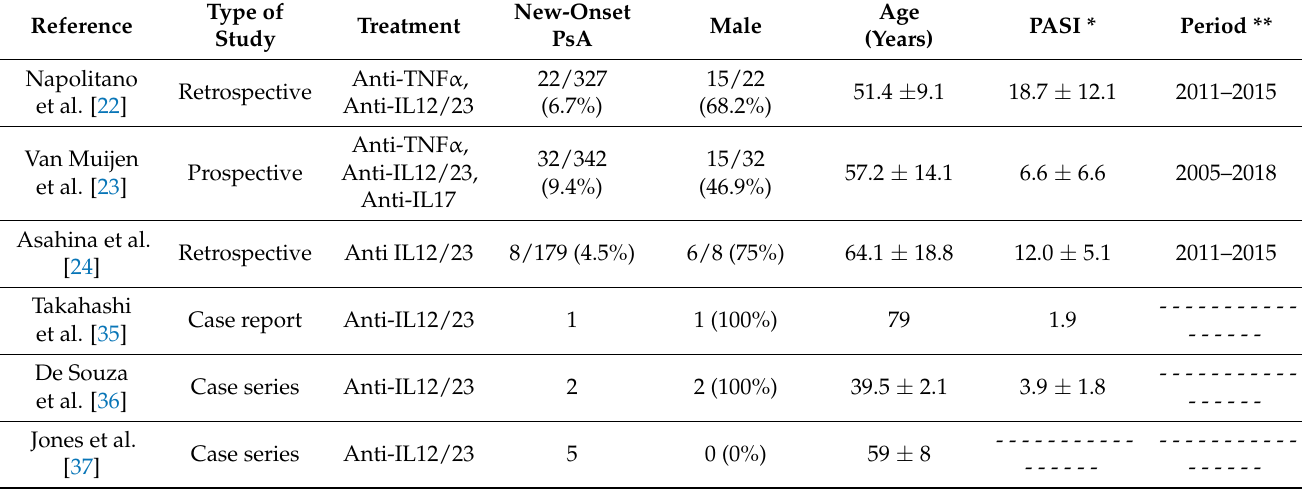
Table 3. Studies reporting the development of new-onset PsA in patients with moderate-to-severe psoriasis treated with biologic therapy. * PASI at the diagnosis of PsA. ** Period of study